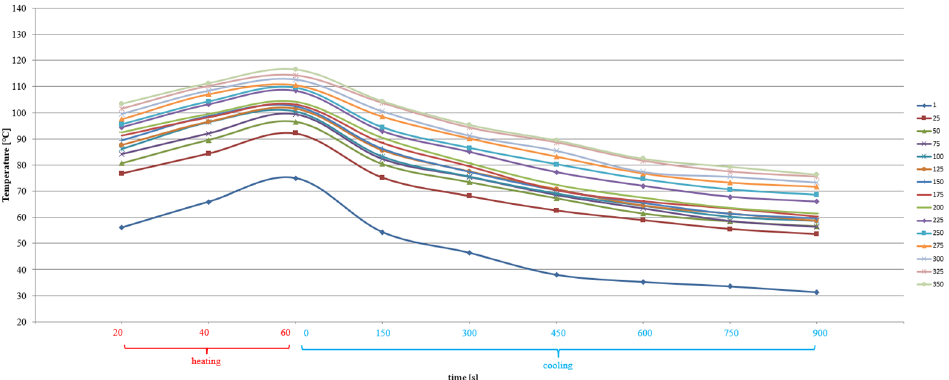
Figure 12. Change of the average temperature of CC-2 concrete as a function of heating and cooling time after a varied number of thermal cycles.